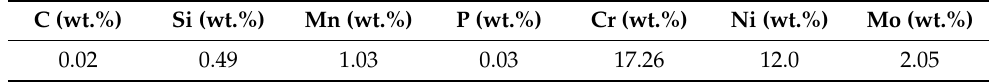
Table 1. Chemical composition of 316L stainless steel.